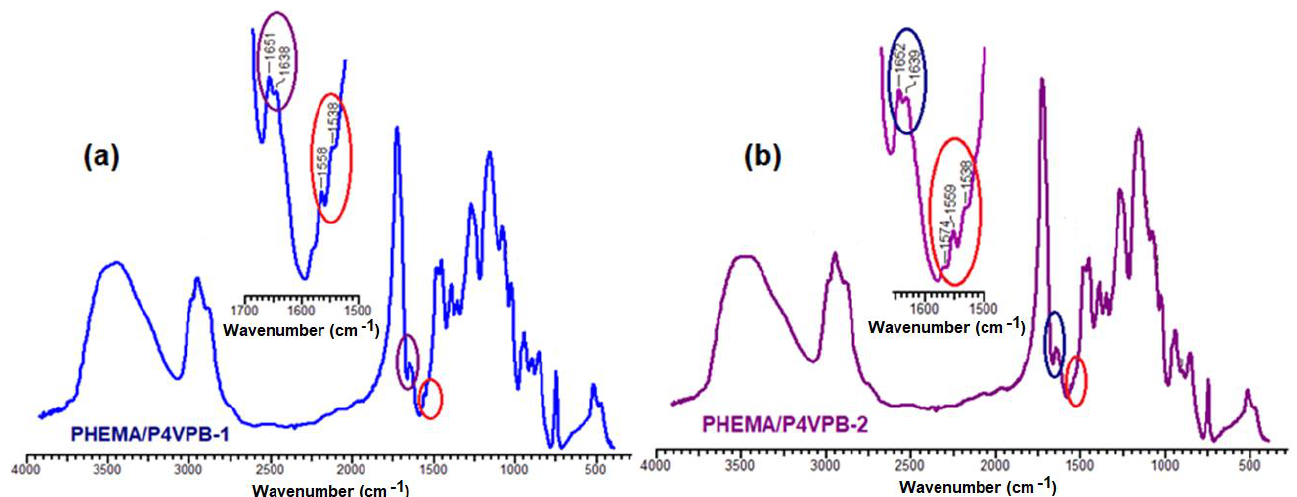
Figure 11. FT-IR spectra of PHEMA/PVPB-1 ( a ) and PHEMA/PVPB-2 ( b ) semi-IPNs.